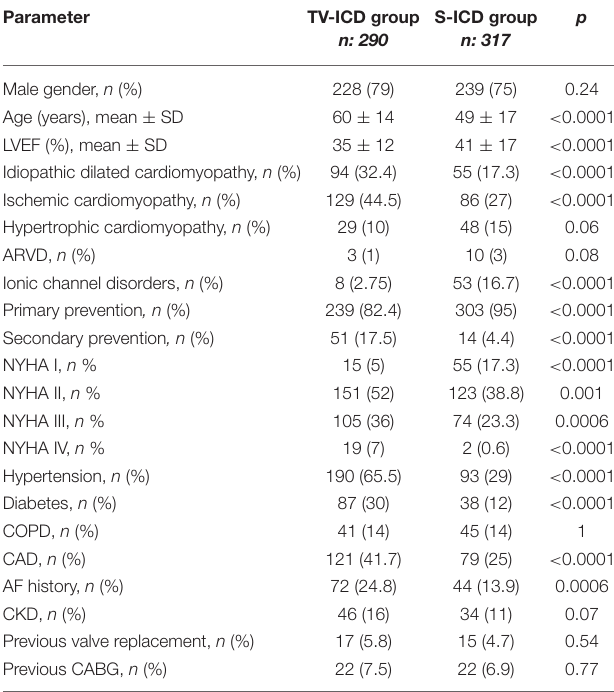
TABLE 1 | Baseline characteristics of the study